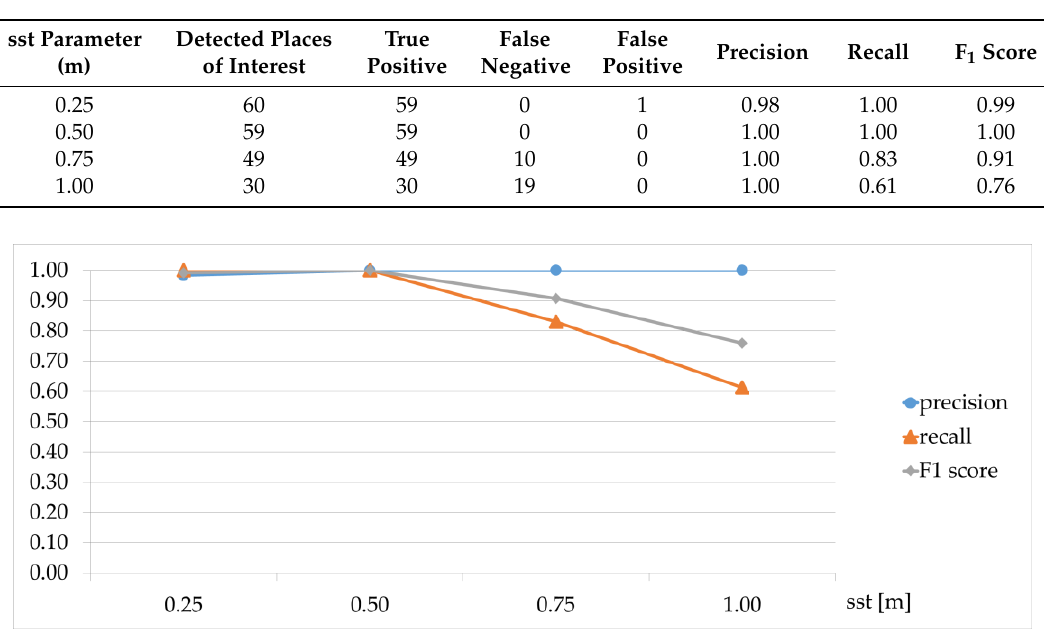
Figure 14. Precision, recall and F 1 score values according to different section step (sst) values. Table 4. Detection of the places of interest results according to various m parameter values. m Parameter m